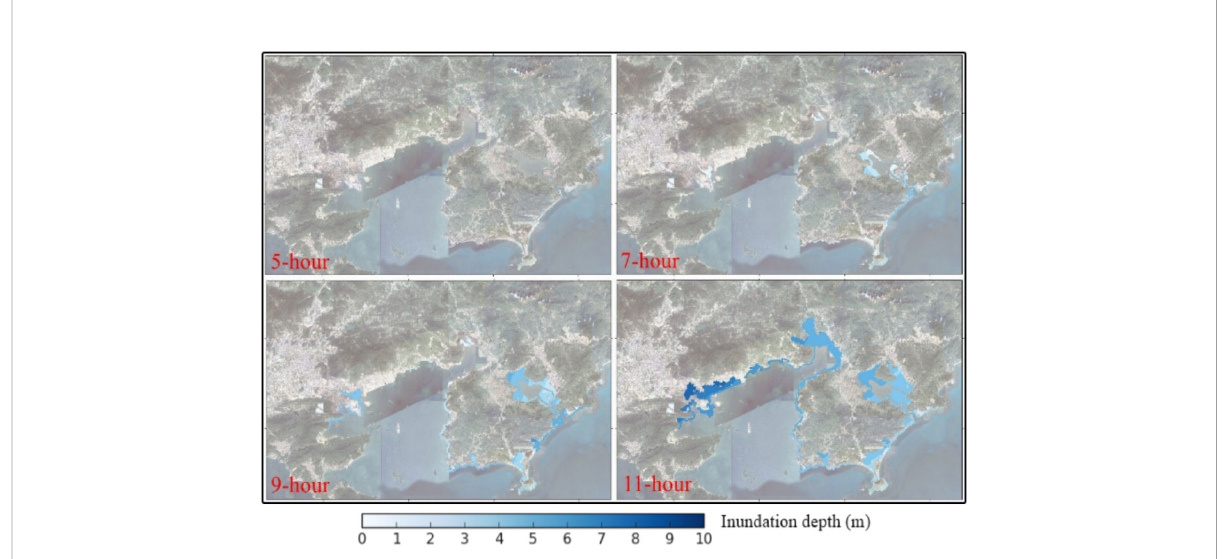
FIGURE 7 The spatially inundated area of storm surge fl ooding from the hydrodynamic simulation for 100-year return period of